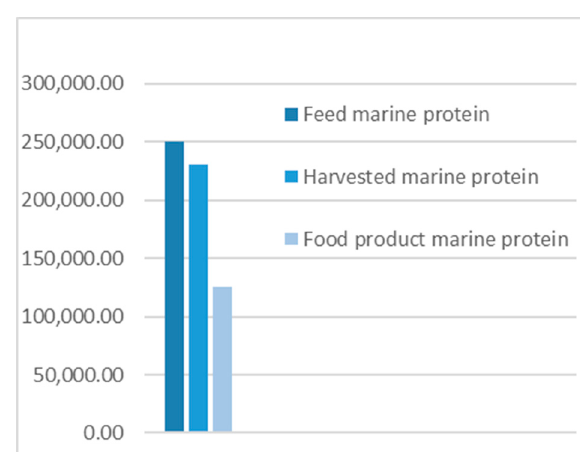
Figure 3. Marine animal protein quantities.